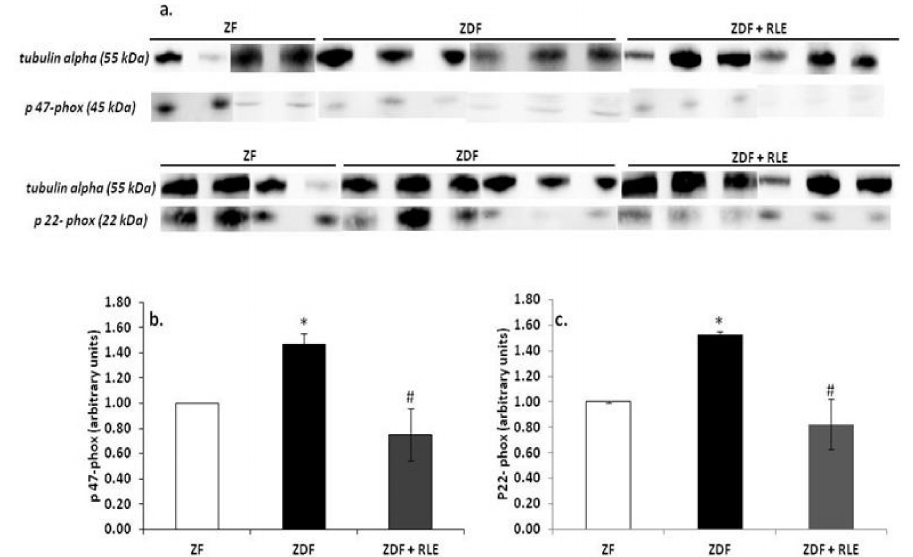
Figure 4. E ff ect of red orange and lemon extract (RLE) on the protein levels of p47-phox and p22-phox in the Zucker Fatty (ZF) ( n = 4), Zucker Diabetic Fatty (ZDF) ( n = 6), and Zucker Diabetic Fatty + red orange and lemon extract (ZDF + RLE) ( n = 6), after 24 weeks of treatment. ( a ) Representative western blot of p47-phox and p22-phox in the ZF, ZDF, and ZDF treated group; ( b ) densitometric analysis of p47-phox; and ( c ) densitometric analysis of p22-phox. Experiments were conducted in triplicates, and the values were normalized towards the tubuline. Densitometric analyses were expressed as arbitrary units. Data are shown as mean ± standard deviation (DS) and were compared by ANOVA (* p < 0.05 versus ZF, # p < 0.05 versus